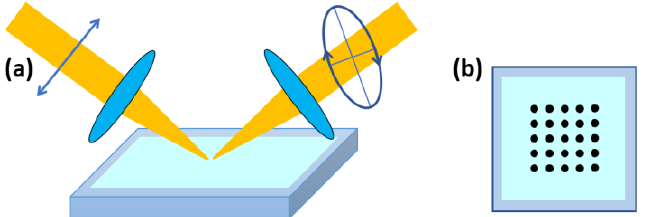
Figure 1. ( a ) A schematic diagram of focused-beam ellipsometry. ( b ) A 5 × 5 measurement grid on DNA films on silicon wafers. The spacing between the measurement points is 1.25 mm.